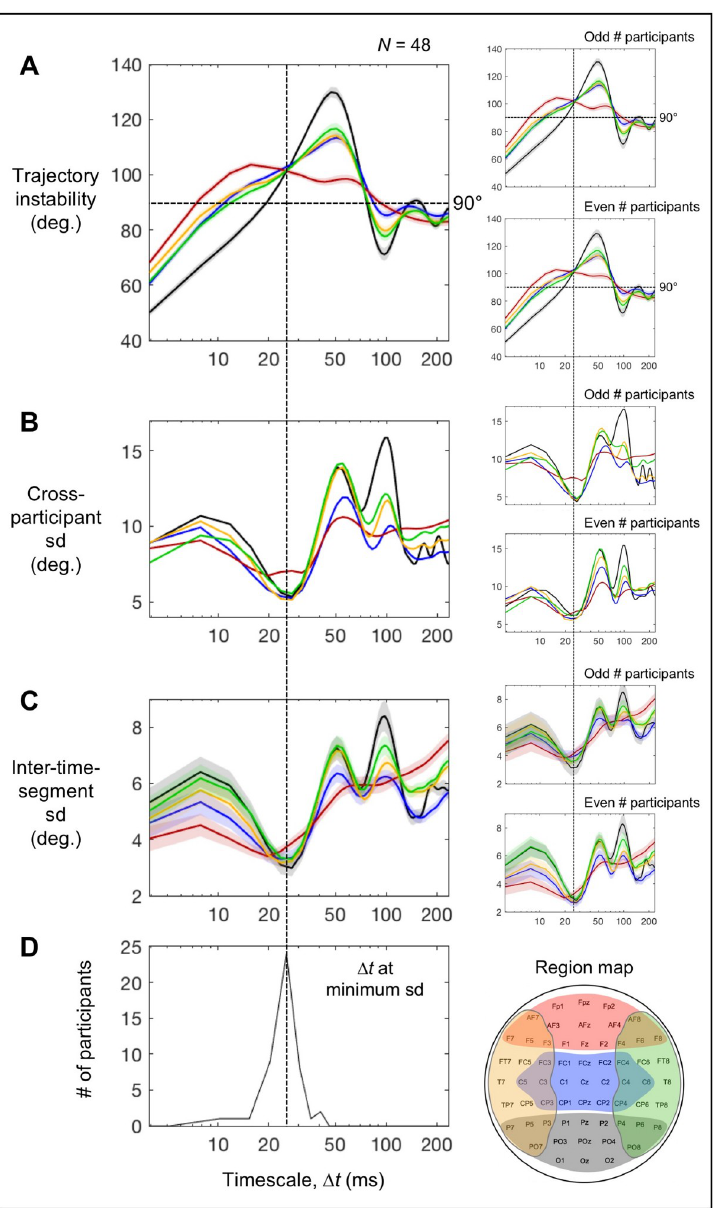
Fig 7. The coincidence of the global convergence (across all five regions) of time-averaged trajectory instability and its minimum variability on the timescale of ~25 ms. The five regions, posterior (black), central (blue), anterior (red), left-lateral (orange), and right-lateral (green), are color coded. A. Time-averaged trajectory instability as a function of timescale Δ t (the same as Fig 3A). B. Cross-participant standard deviation of time-averaged trajectory instability as a function of timescale Δ t . C. Inter-time-segment standard deviation (trajectory instability averaged within each time segment) as a function of timescale Δ t . D. Histogram of the timescale values that minimized the inter- time-segment standard deviation (computed based on the standard-deviation values averaged across all five regions). The vertical dashed lines show that time-averaged trajectory instability globally (across all regions) converged and achieved minimum variability (in terms of both cross-participant and inter-time-segment variability) on the timescale of ~25 ms. The shaded areas represent ± 1 standard error of the mean. In C , standard errors have been adjusted to reflect the cross-participant consistency of timescale dependence independently of baseline individual differences (relevant to estimating the location of the global minimum) (Morey, 2008). For each plot, the reliability of the data patterns is demonstrated by the accompanying plots on the right showing virtually identical patterns obtained from the odd and even numbered participants.